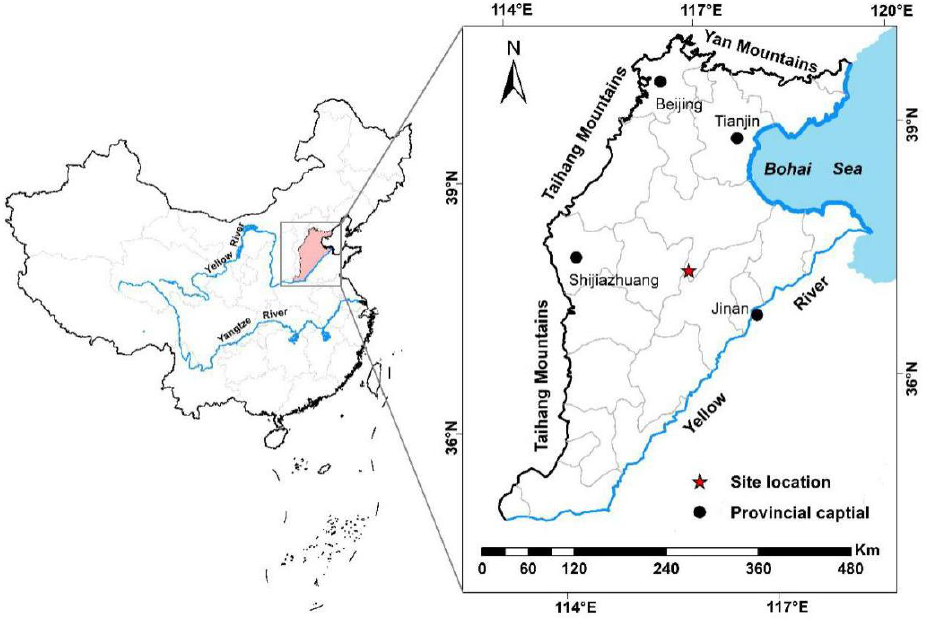
Figure 1. Location of Wuqiao County and the North China Plain.